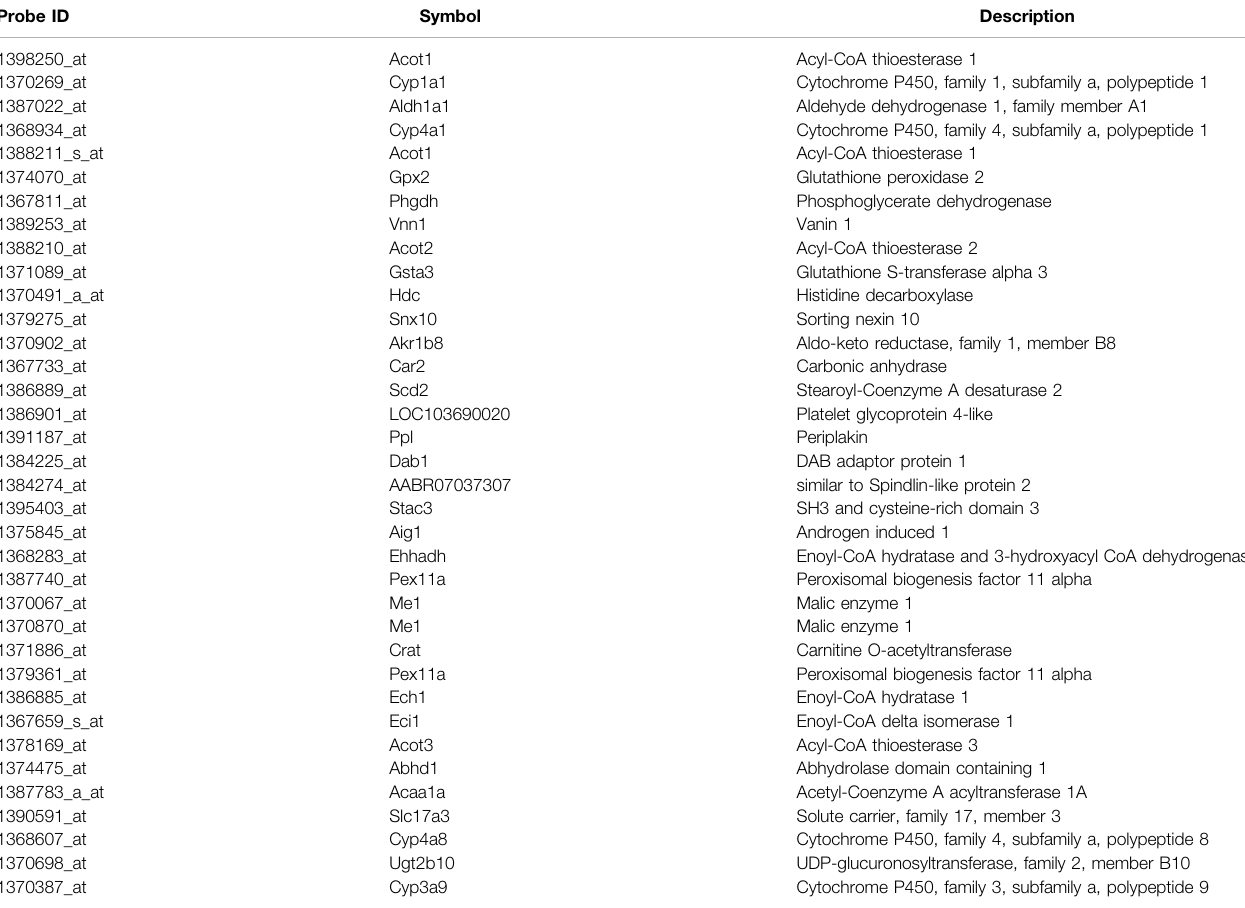
TABLE 2 | Principal components relating common genes in a virtual microarray (RAID) and in vivo data.